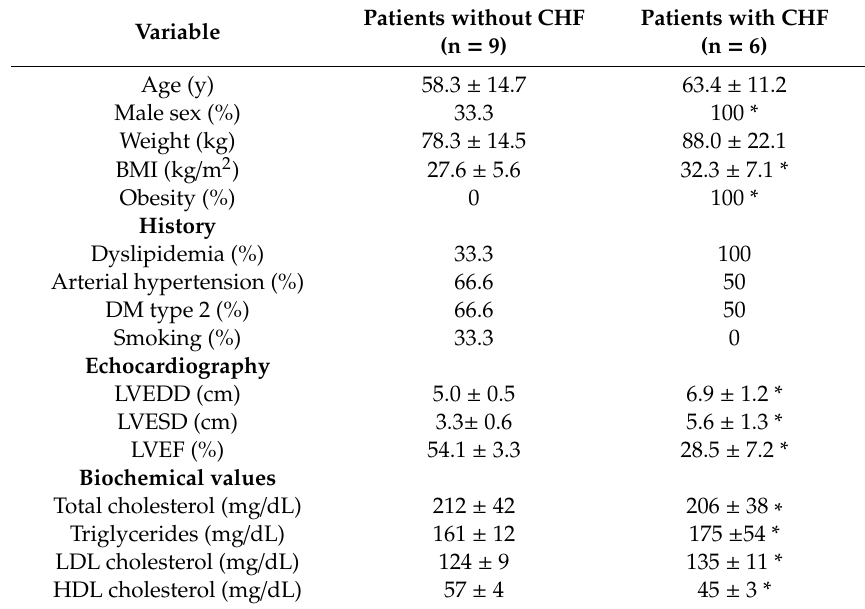
Table 1. Demographic, clinical, hemodynamic, and biochemical characteristics of CAD